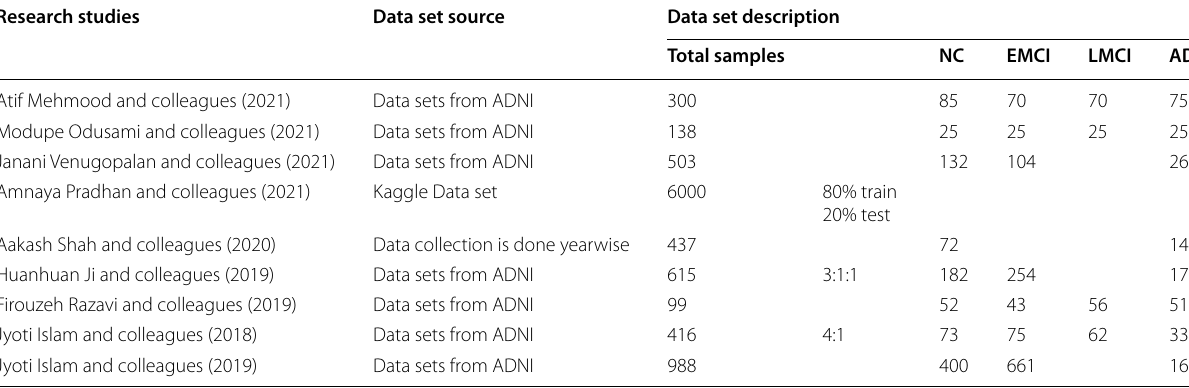
LC: Normal Control; LMCI: Late Mild Cognitive Impairment; EMCI: Early Mild Cognitive Impairment; AD: Alzheimer’s